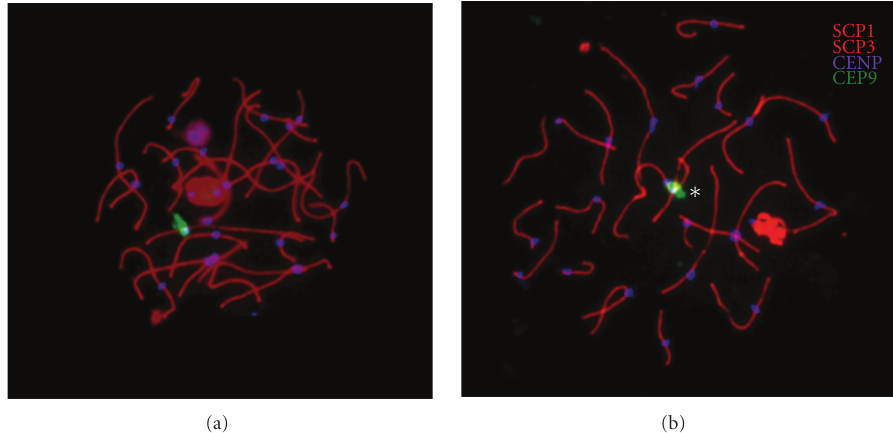
Figure 4: Images show pachytene cells with the bivalent 9 synaptonemal complex identified by FISH analysis. (a) Representative image from a control donor. (b) Representative image from the 9qh+++ patient. An asterisk indicates the loop in the pericentromeric region; SCP1 and SCP3 indicate synaptonemal complexes in red; CENP indicates centromere in blue, and chromosome enumeration probe 9 (CEP9) indicates bivalent 9 in